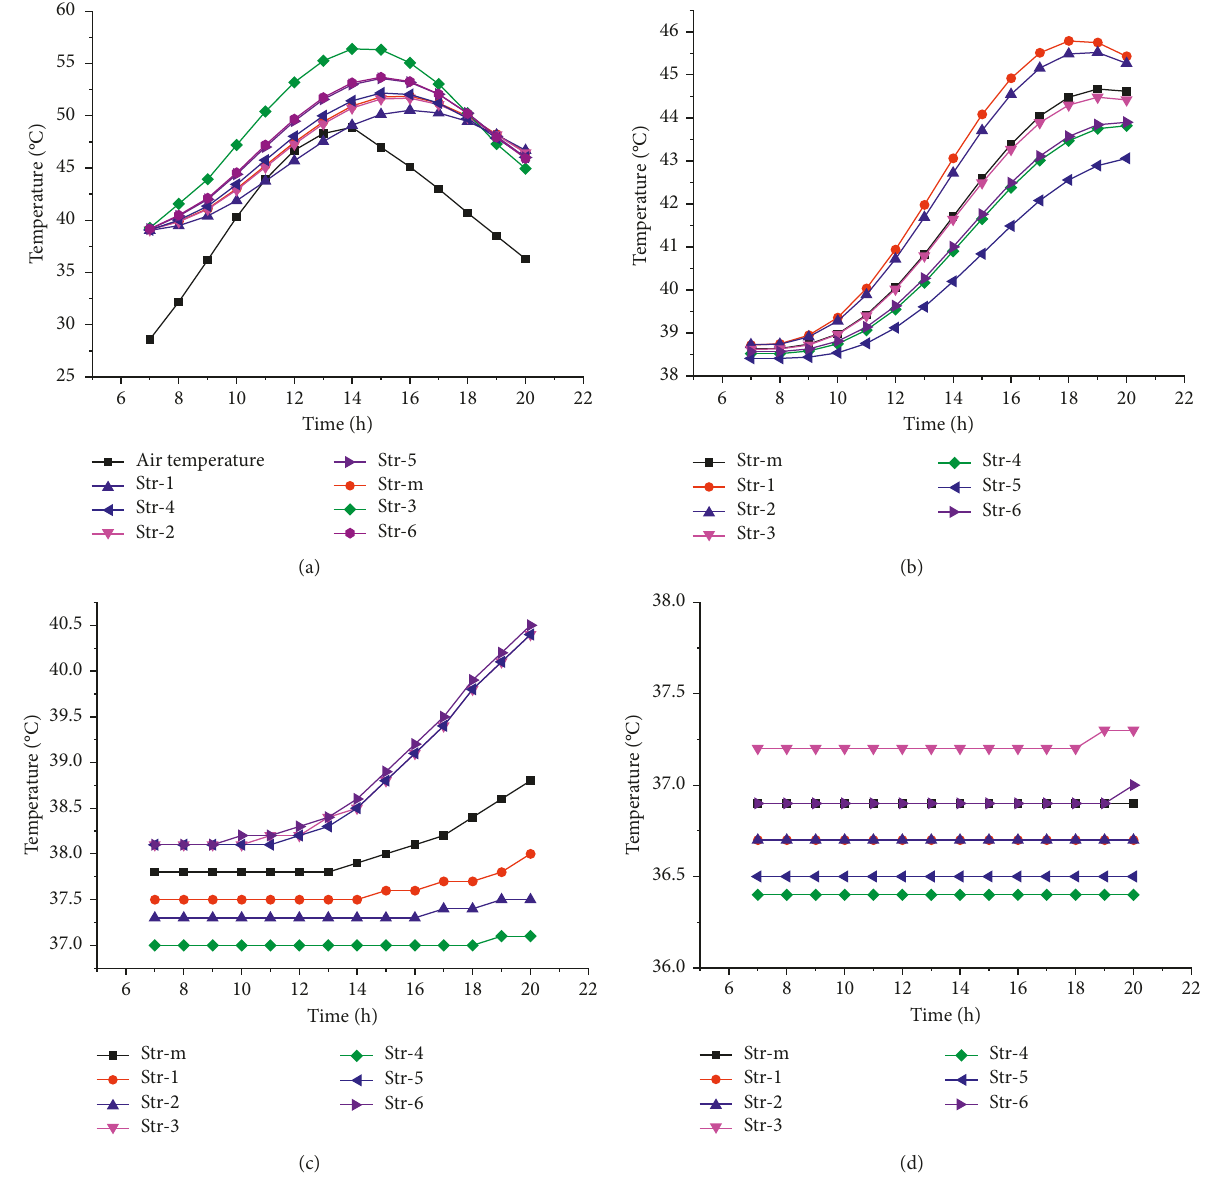
Figure 14: Structure temperature at different depths: (a) temperature variation at the bottom of upper asphalt surface courses, (b) temperature variation at the bottom of lower asphalt surface courses, (c) temperature variation at the bottom of upper base courses, and (d) temperature variation at the bottom of lower base